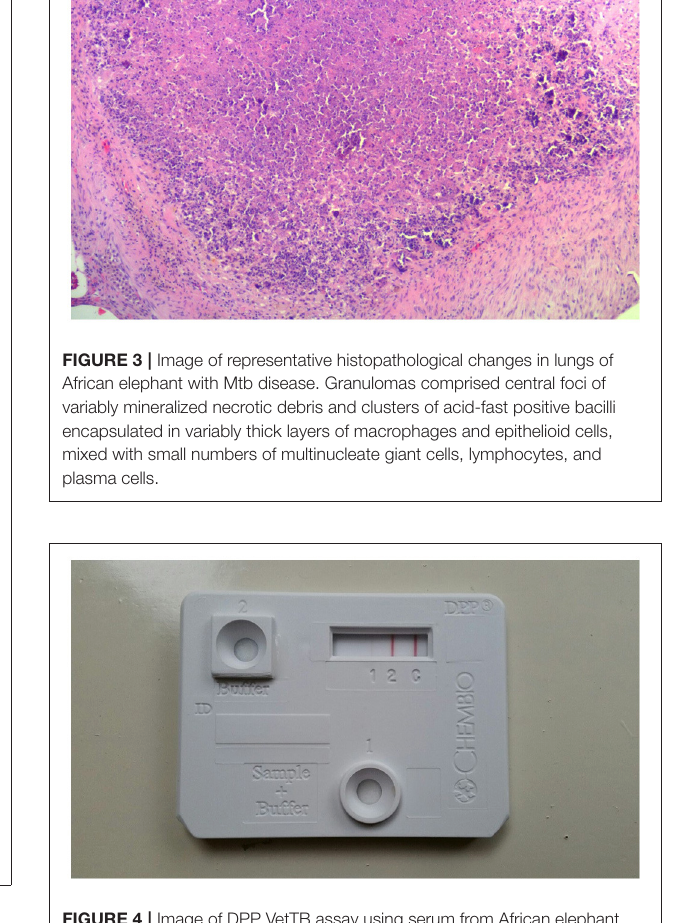
FIGURE 4 | Image of DPP VetTB assay using serum from African elephant with Mtb disease. Serology methods were performed as previously described (18). Visible band at test line 2 demonstrates presence of antibodies to ESAT-6/CFP10 fusion protein, which are Mtb complex specific